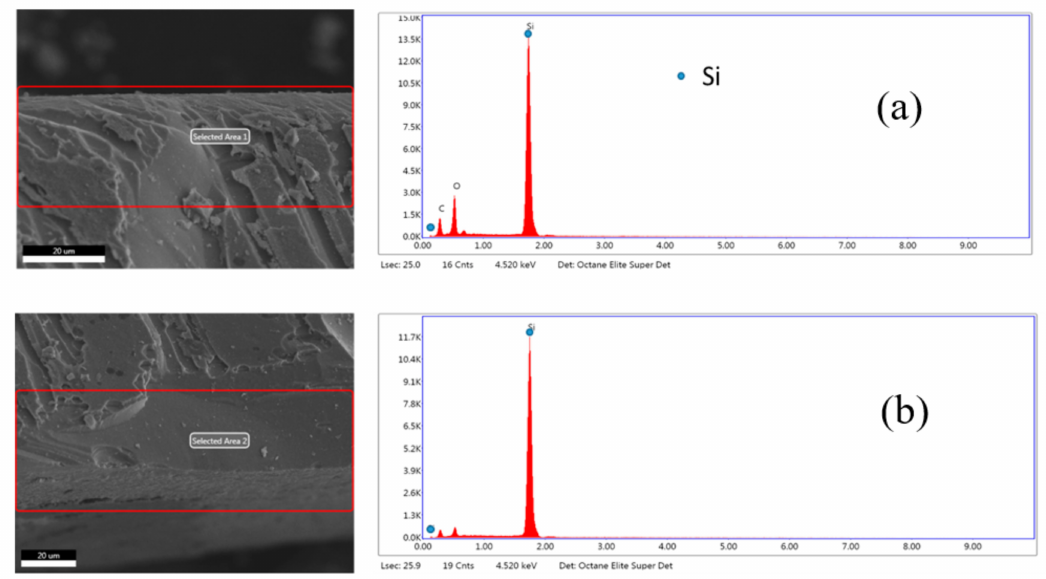
Figure 5. The SEM-EDS diagram of PV cells after purification. ( a ) Upon of the cell, the structures of antireflection layer, texturization were removed. ( b ) Back side of the cell, the structure of Al electrode was removed.